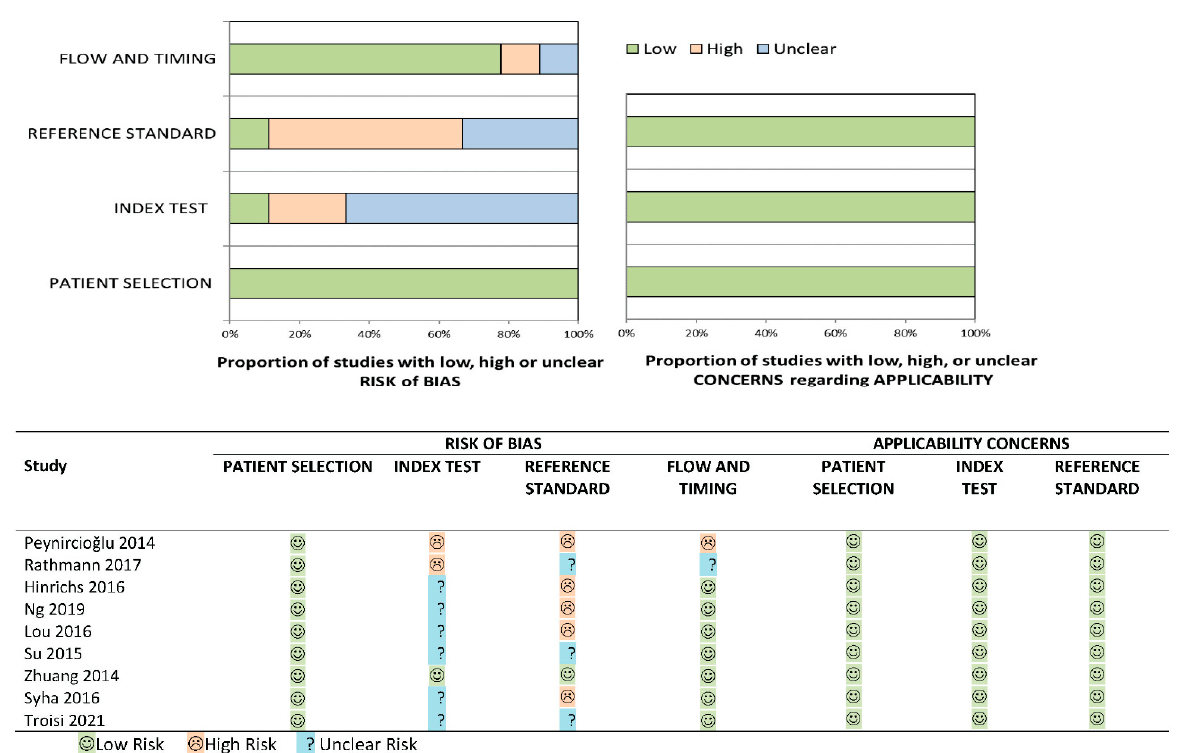
Figure 2. Bias and quality assessment of the included studies according to QUADAS-2.